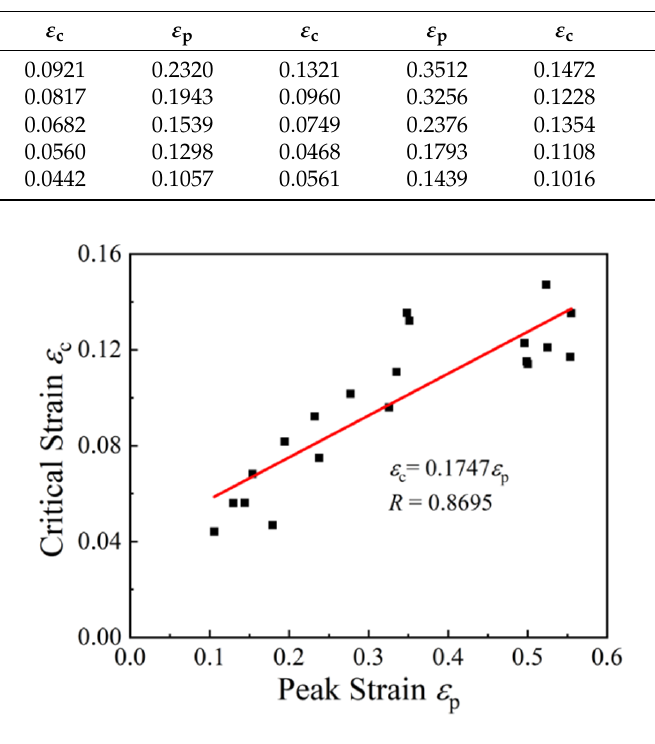
Figure 6. Relationship of ε c ~ ε p